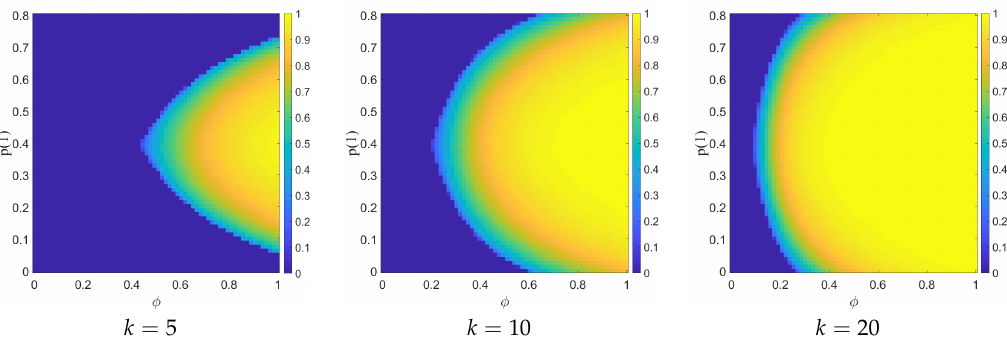
Figure 4. Phase planes of the bond CAP for three exclusive colors, with one trusted color with fixed probability p ( 3 ) = 0.2, varying the average connectivity k of the